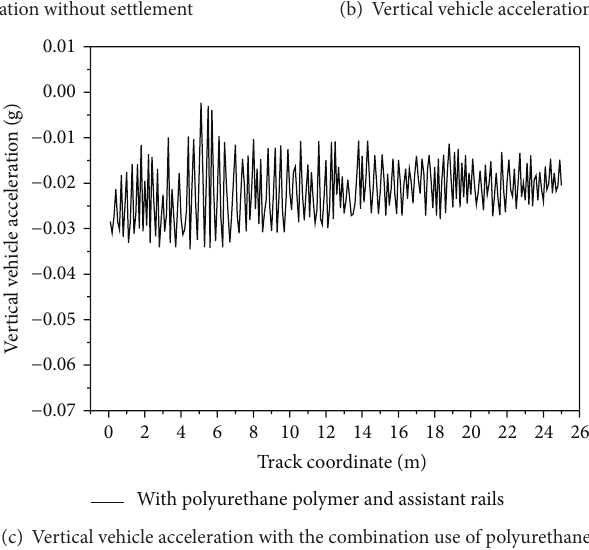
Figure 9: The acceleration of a wagon traveling from the bridge to the